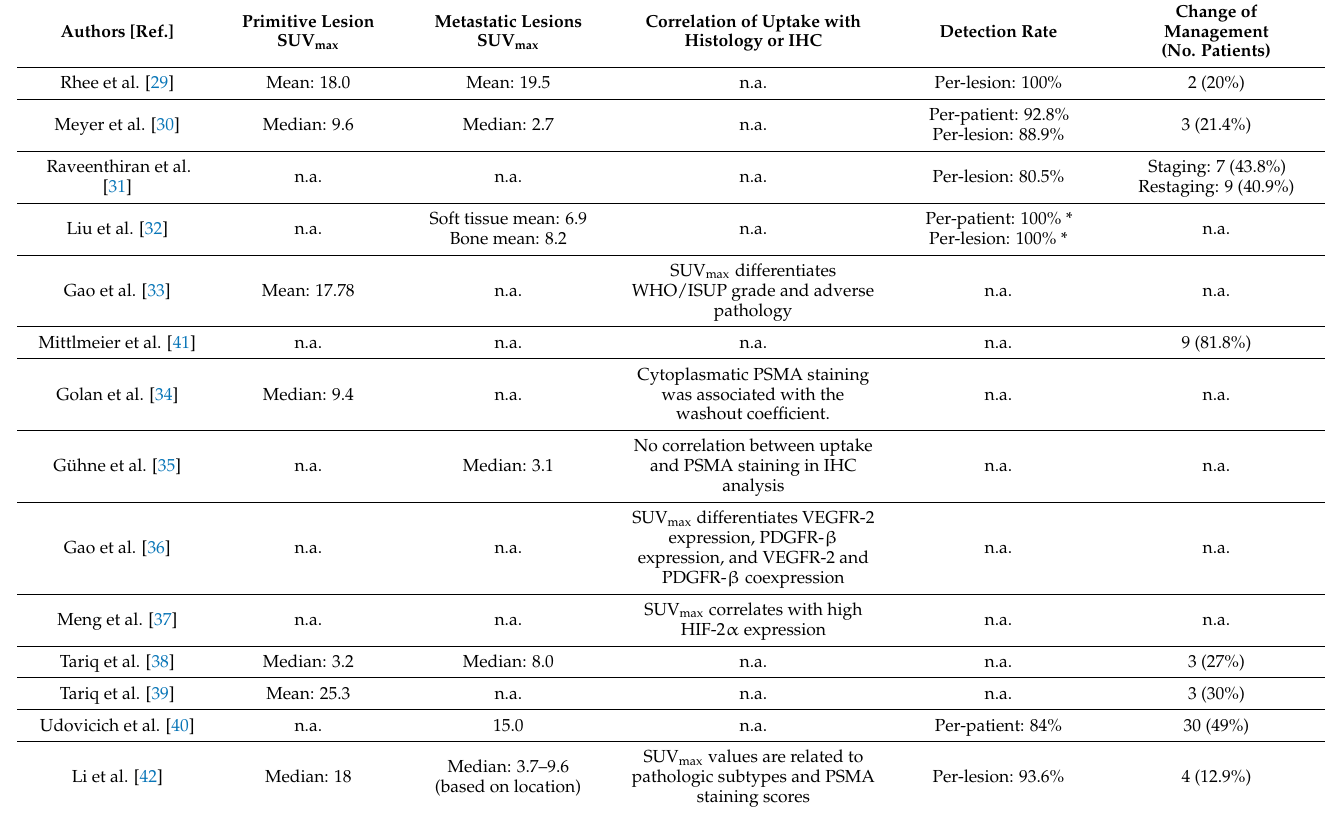
Table 4. Outcomes of the included